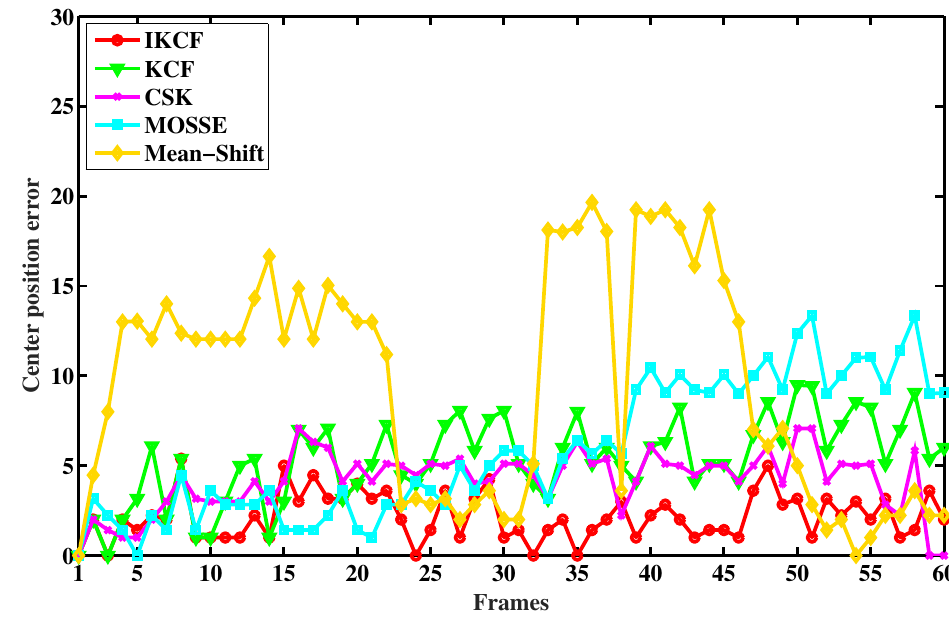
Figure 5. Center position error curves (1st frame to 60th